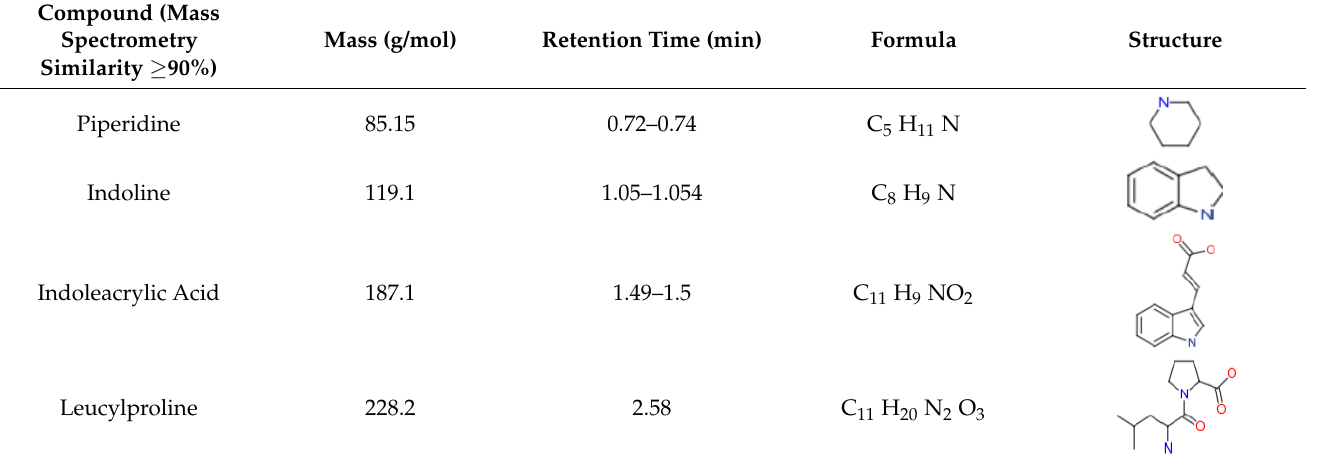
Table 2. Detected compounds from untargeted metabolite screening with the UPLC-HDMS. Compound (Mass Spectrometry Similarity ≥90%)